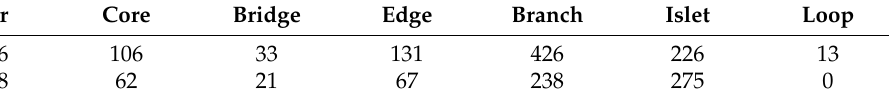
Figure 9. Morphological spatial patterns of historical forests in ( a ) 1976 and ( b ) 2018.